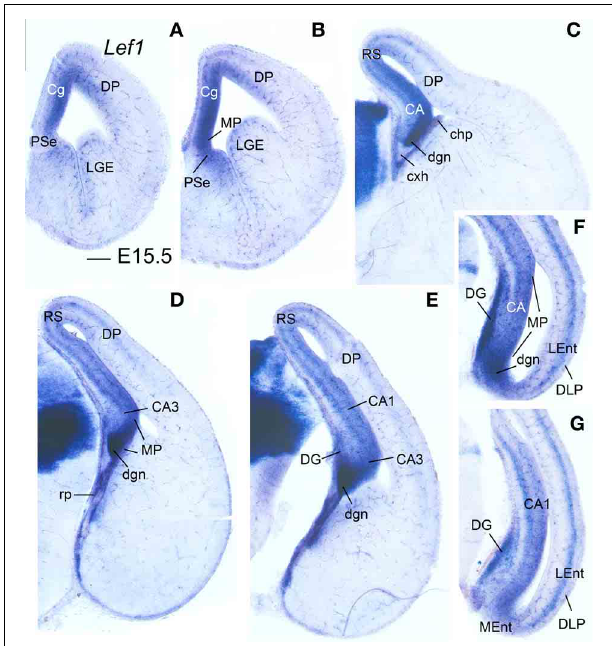
FIGURE 3 | Expression of Lef1 in mouse embryonic telencephalon at E15.5. Digital images of coronal sections of mouse embryonic telencephalon (E15.5), from rostral (A) to caudal (G) levels, hybridized for Lef1 . The medial pallial (MP) vz and derivatives show expression of Lef1 . Note the lack of Lef1 expression in the vz of the dorsolateral caudal pallium (DLP), giving rise to LEnt. For abbreviations see list. Scale bar: (A) = 200 μ m (applies to